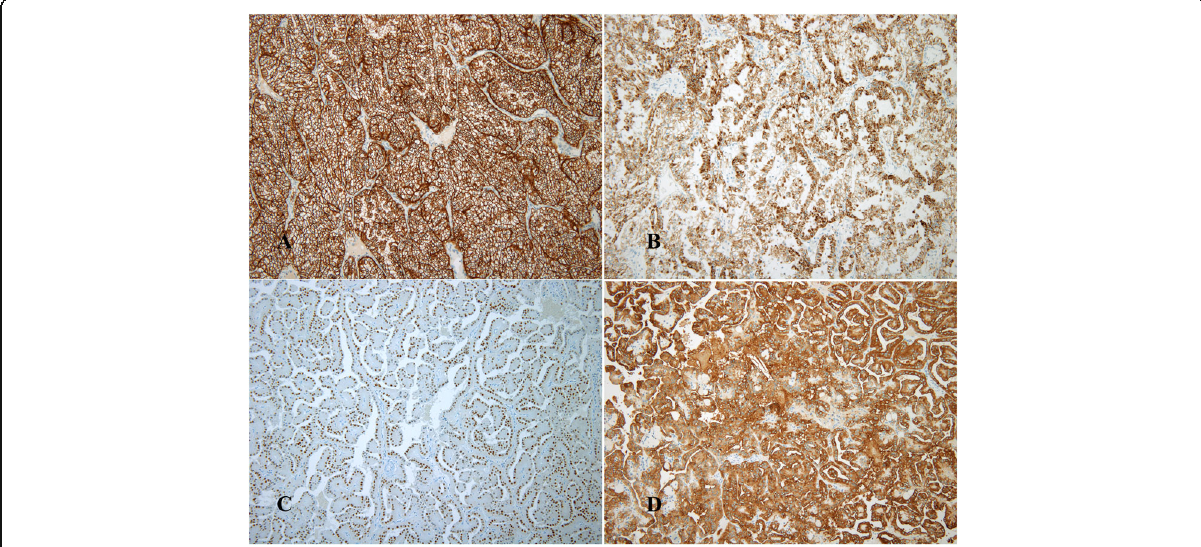
Fig. 2 Immunohistochemical stain for CAIX in clear cell renal cell carcinoma shows membranous positivity ( a ). AMACR shows cytoplasmic positivity in clear cell renal cell carcinoma ( b ). GATA3 in papillary renal neoplasm with reverse polarity (PRNRP) shows strong nuclear positivity ( c ). CK7 shows diffuse cytoplasmic positivity in PRNRP ( d